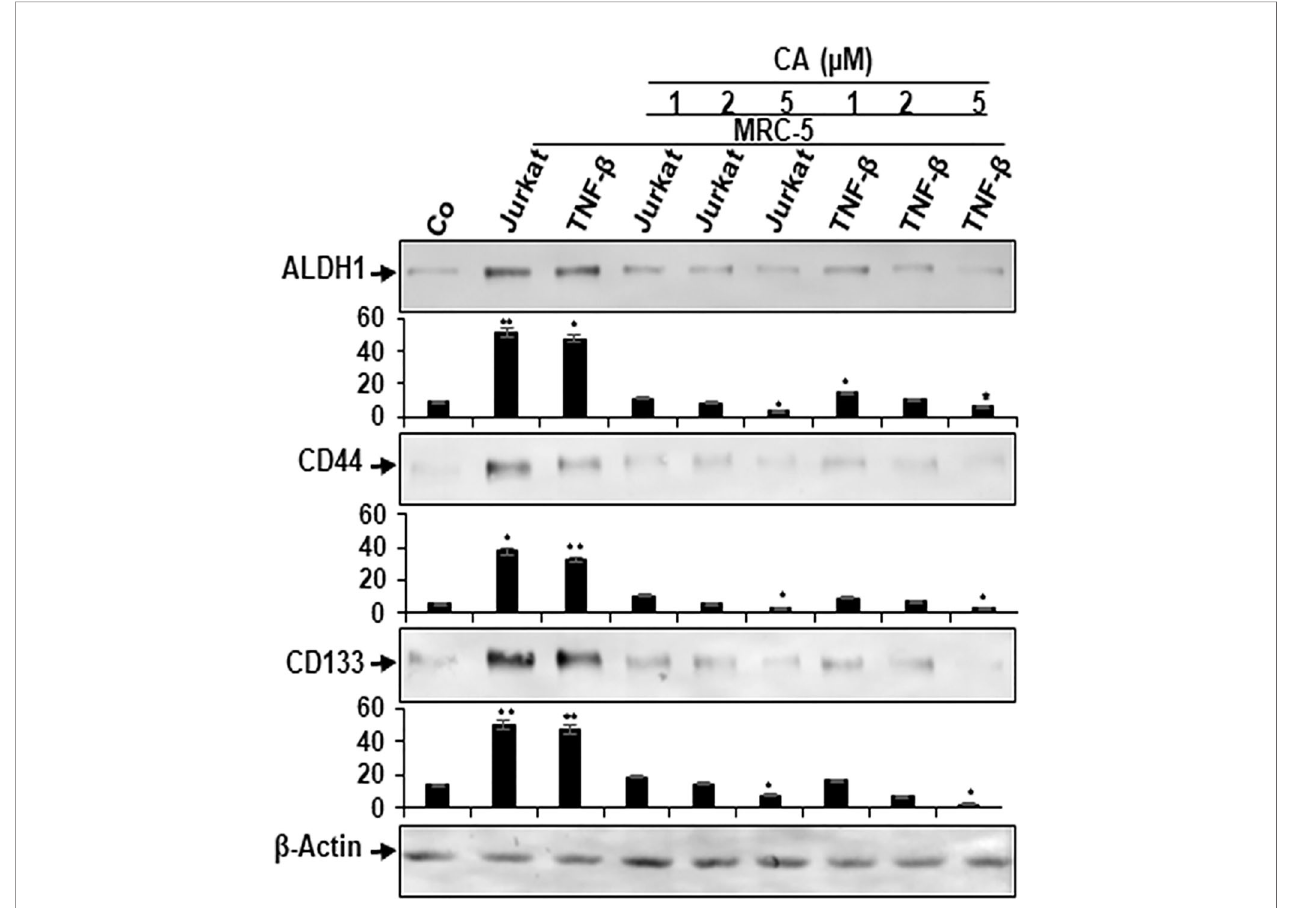
FIGURE 6 | Effect of Calebin A on multicellular proin fl ammatory TME-induced activation of cancer stem cells. Serum-starved cultures of HCT116 cells in 3D- alginate cultures alone (basal control = co) or co-cultured with fi broblasts and T-lymphocytes (proin fl ammatory multicellular TME cultures) or co-cultured with fi broblasts and TNF- b (10 ng/ml) (TNF- b -TME) were either left untreated or treated with various concentrations of Calebin A (CA) (1, 2, and 5 µM), as described in Materials and Methods . Immunoblotting of whole-cell lysates from HCT116 cells was performed for anti-CD133, anti-CD44, and anti-ALDH1 in HCT116 cells. b -Actin served as an internal loading control in all experiments. Densitometric values were compared with the control, and * p < 0.05 and ** p < 0.01 were considered statistically signi fi